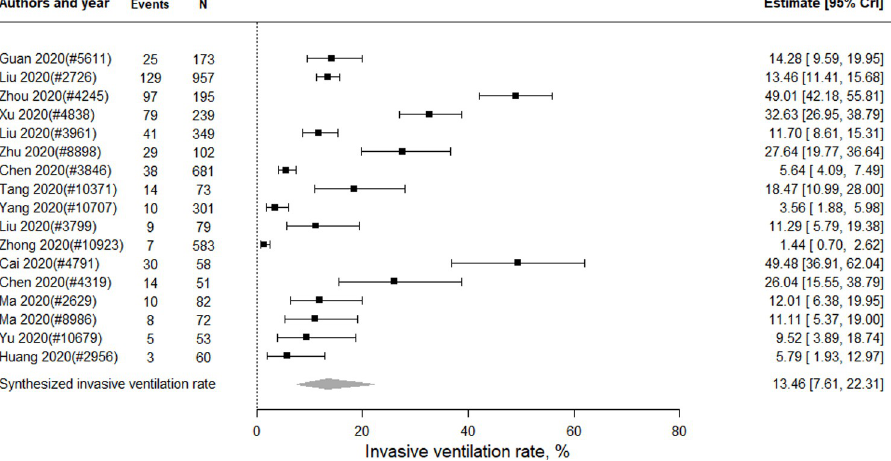
Fig 5. The use of invasive ventilation rate by severe or critical COVID-19 patients in